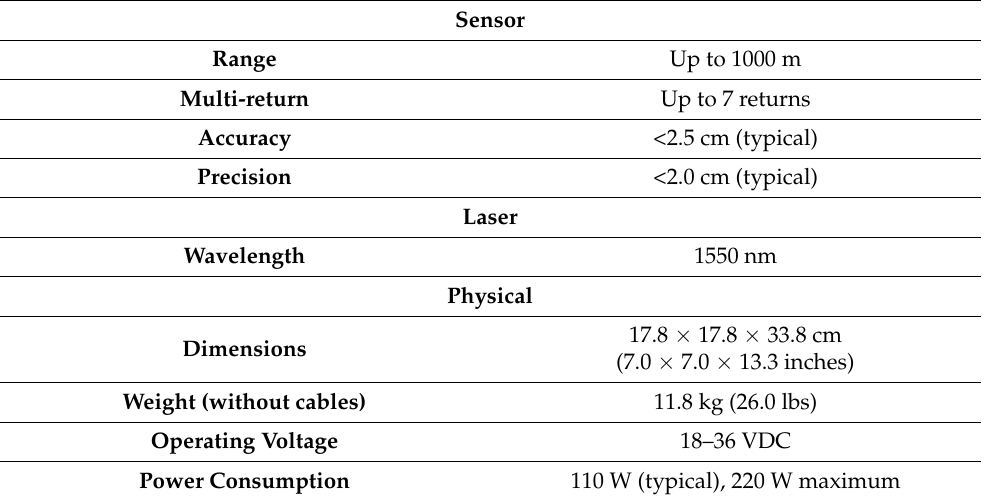
Table 3. OPAL™ 3D LiDAR.